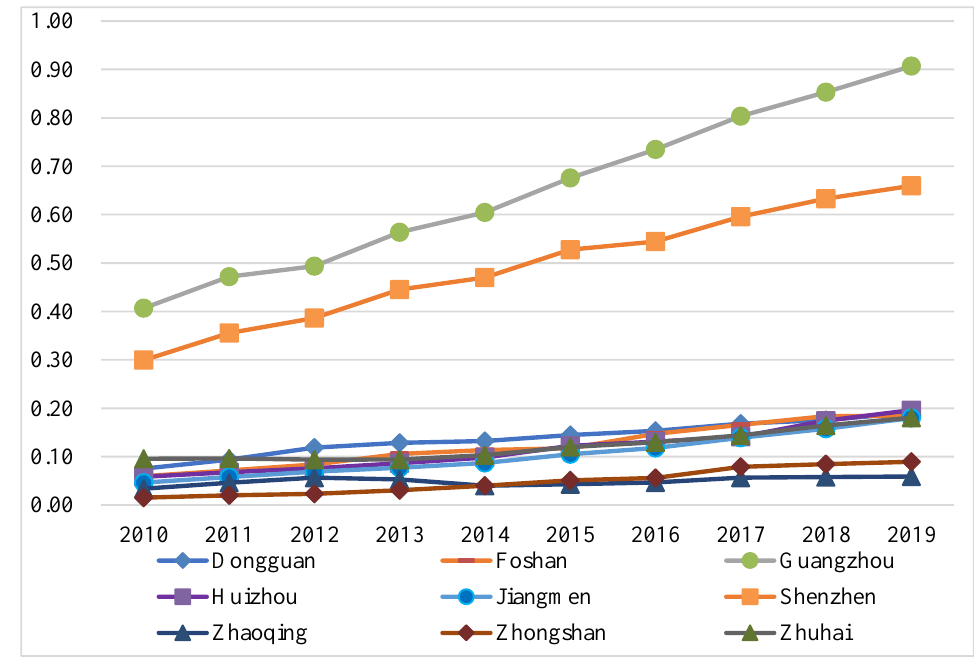
Figure 5. The benefit index of the tourism system in nine cities in the PRD.